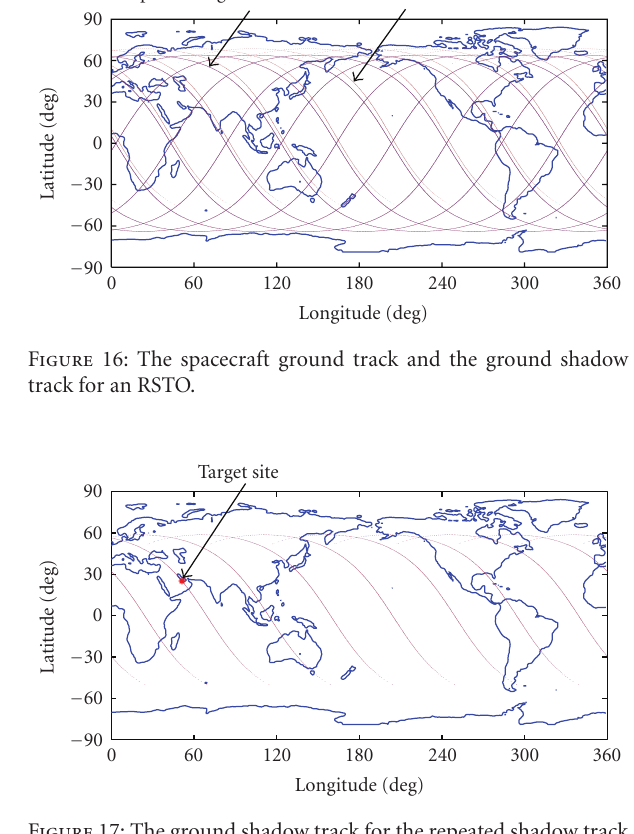
Figure 17: The ground shadow track for the repeated shadow track orbit obtained by genetic